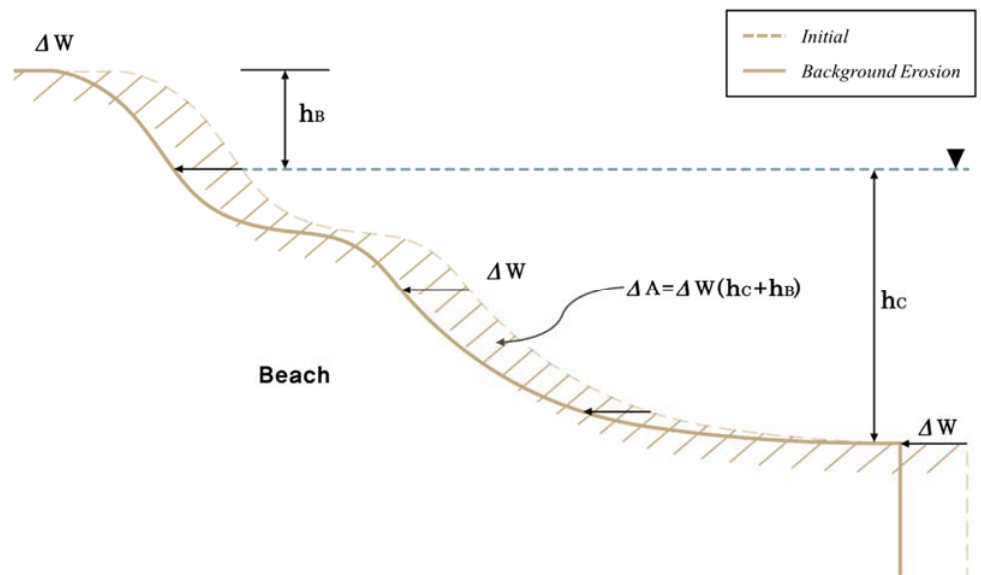
Figure 5. Background erosion from a reduction in sediment budget.